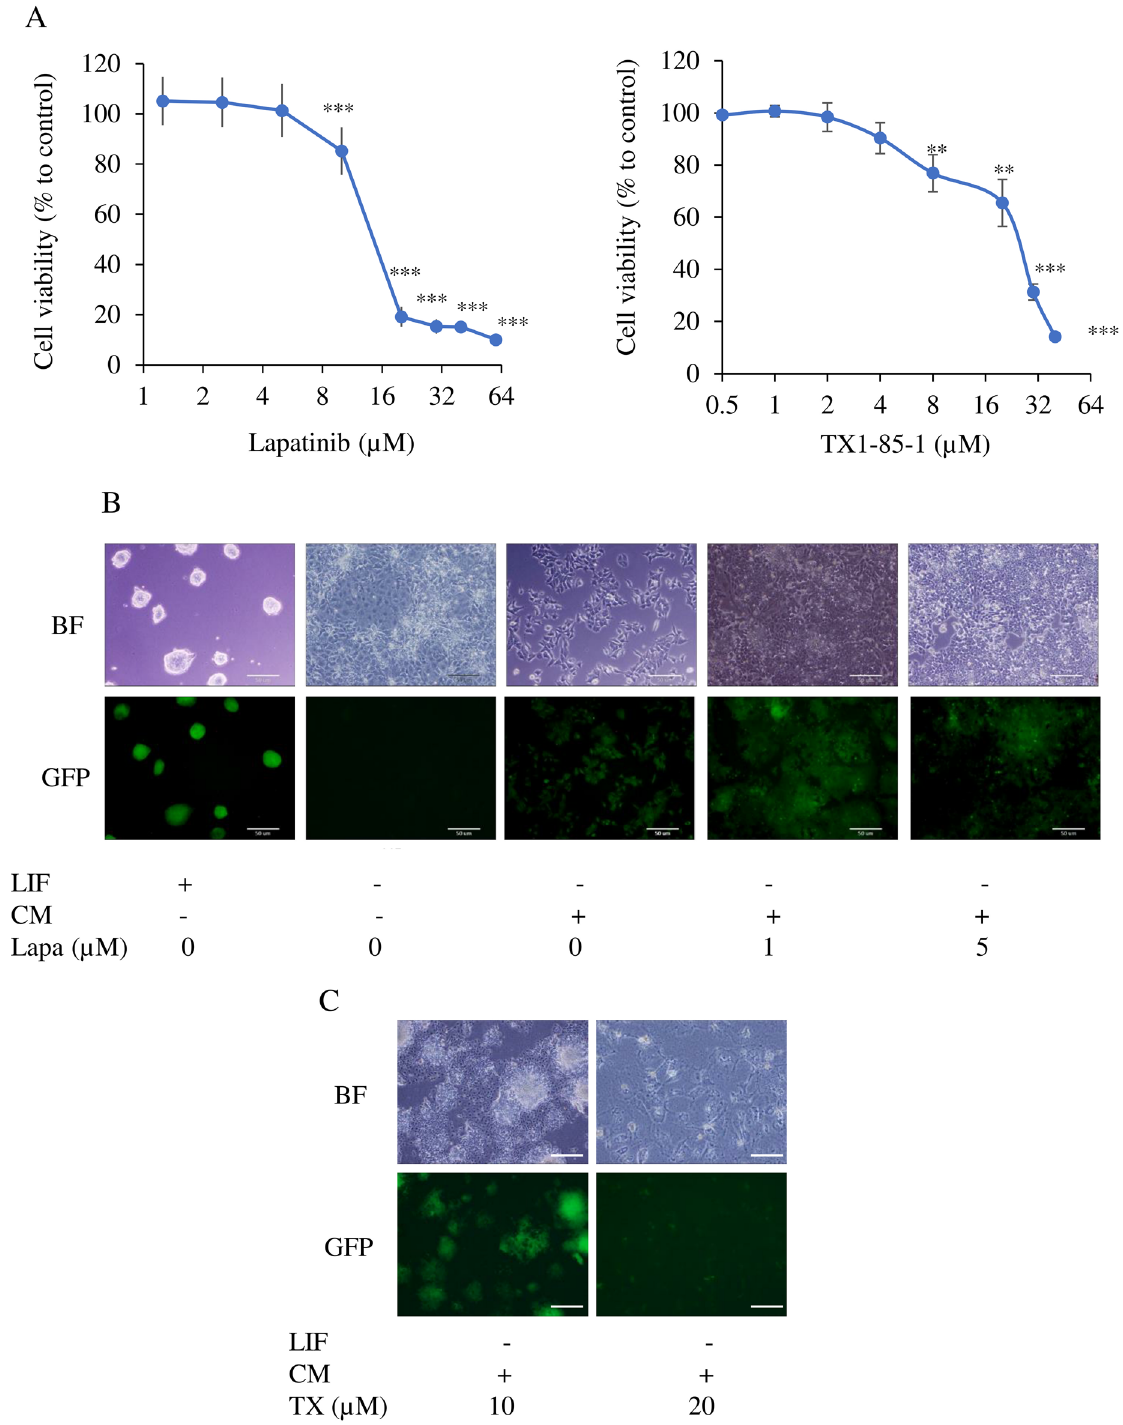
Figure 3. The effect of lapatinib and TX1-85-1 on miPSCs in the presence of CM of PK8 cells. ( A ) Cell viability evaluated by MTT assay. **, p < 0.005; ***, p < 0.001. ( B,C) Representative bright-field (BF) and fluorescence (GFP) images of cells after one week of culturing in different conditions with or without LIF, CM, and lapatinib (lapa) at 1 or 5 µM or TX1-85-1 (TX) at 10 or 20 µM. Scale bars = 50